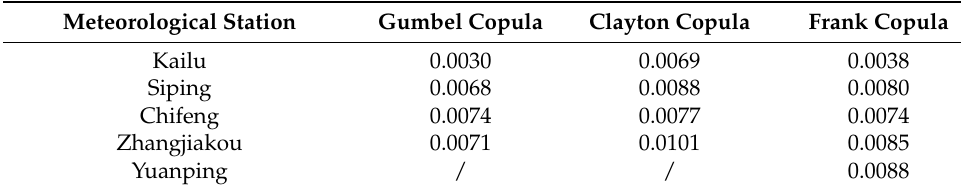
Table 3. Sum of squares of deviations for